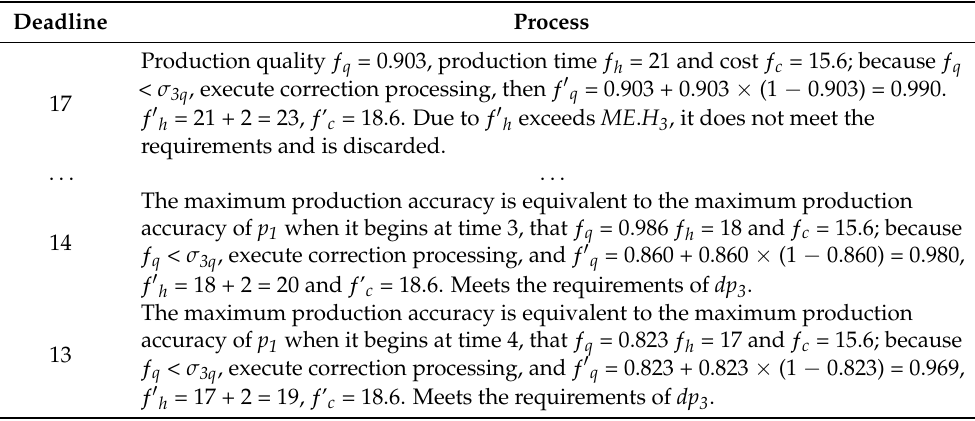
Table 5. Scheduling process and result of p (cid:48) [10–12] under different deadlines.